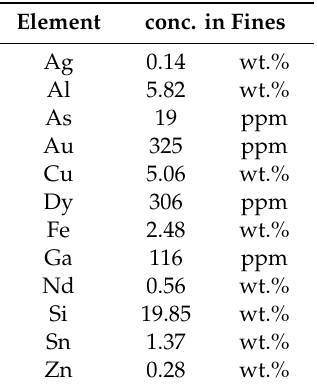
Table 1. Elemental composition of fines. Element